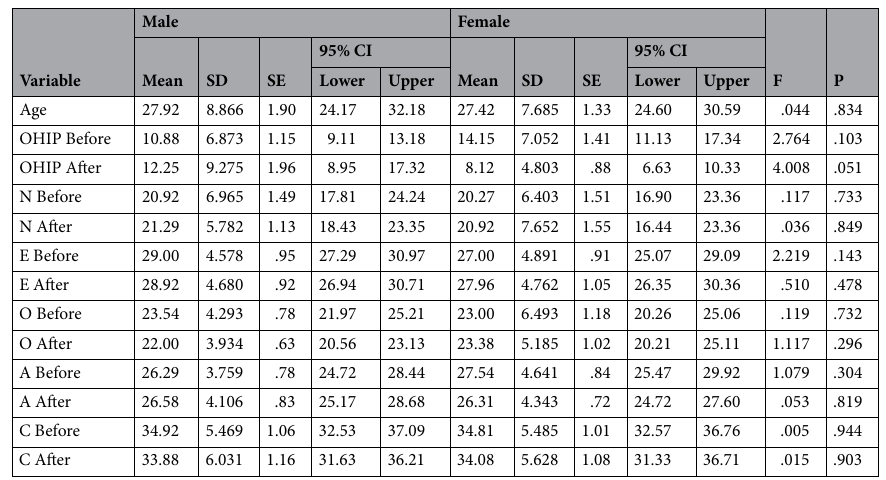
Table 2. Gender differences and distribution of means, standard deviation, standard errors, and 95% confidence intervals of age, OHIP scores before and after treatment, and NEO-FFI scores before and after treatment among the study participants (n = 50, 24 males and 26 females). SD = Standard deviation, SE = Standard error of the mean, CI = 95% confidence intervals of the mean, OHIP = Oral Health Impact Profile score, Before = Before treatment, After = After treatment, N = Neuroticism, E = Extraversion, O = Openness, A = Agreeableness, C = Conscientiousness, F = F Statistic value using ANOVA test to compare males and females groups (degree of freedom = 1 between groups and 48 within groups), P = Probability value.